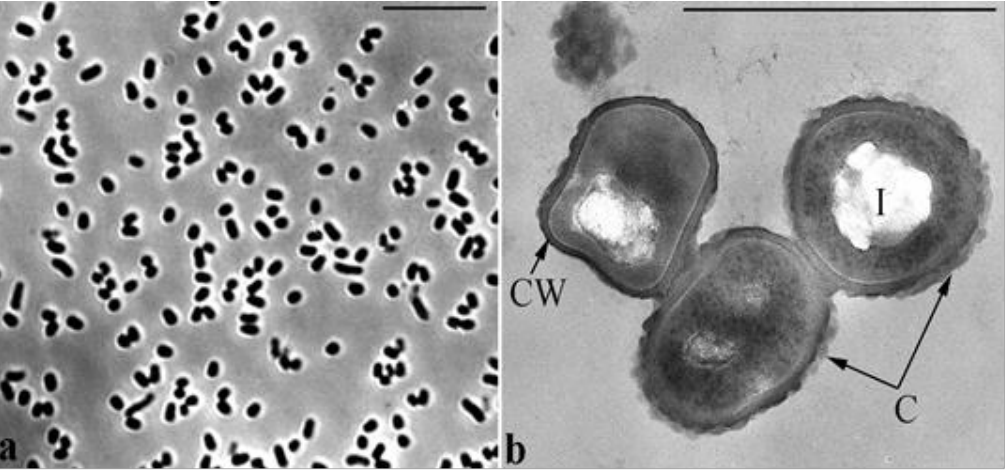
Figure 1. Morphology of strain BS3 cells: ( а ) phase contrast; scale bar, 10 μm; ( b ) ultrathin section; scale bar, 1 μm. Designations: CW, cell wall; C, capsule; I, electron -transparent inclusion.